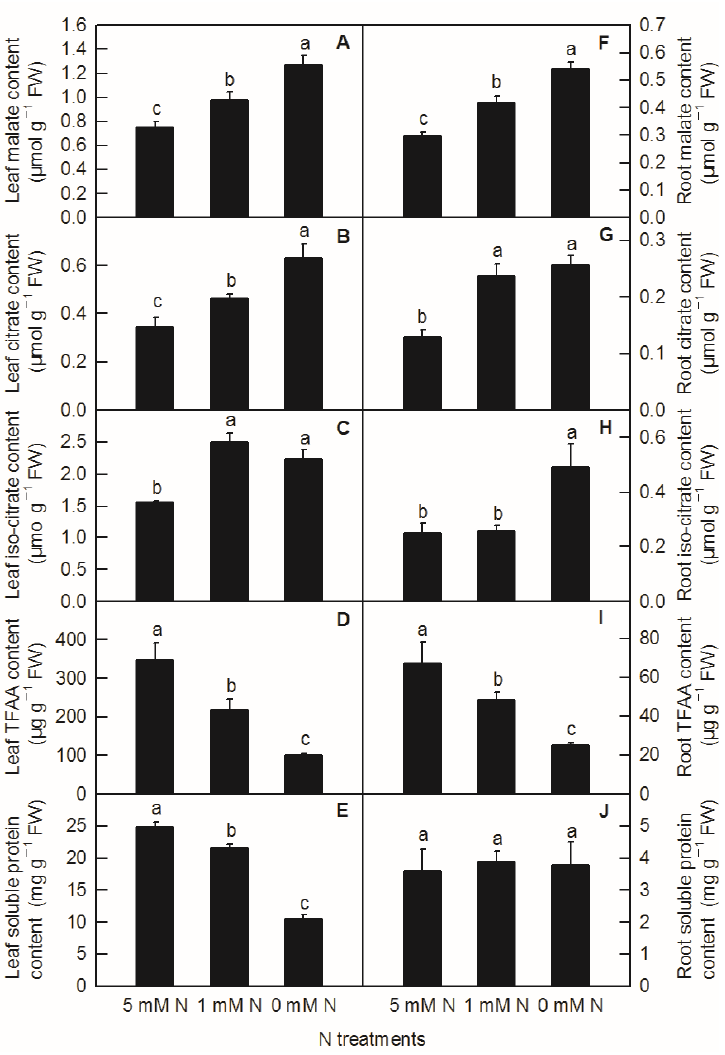
Figure 3. Effects of N deficiency on the contents of organic acids, TFAA, and soluble proteins in O. sativa leaves ( A – E ) and roots ( F – J ). Bars represent means ± SD ( n = 3). Difference among the treatments was analyzed by Duncan’s multiple range test. Different letters above the bar indicate a significant difference at p < 0.05.